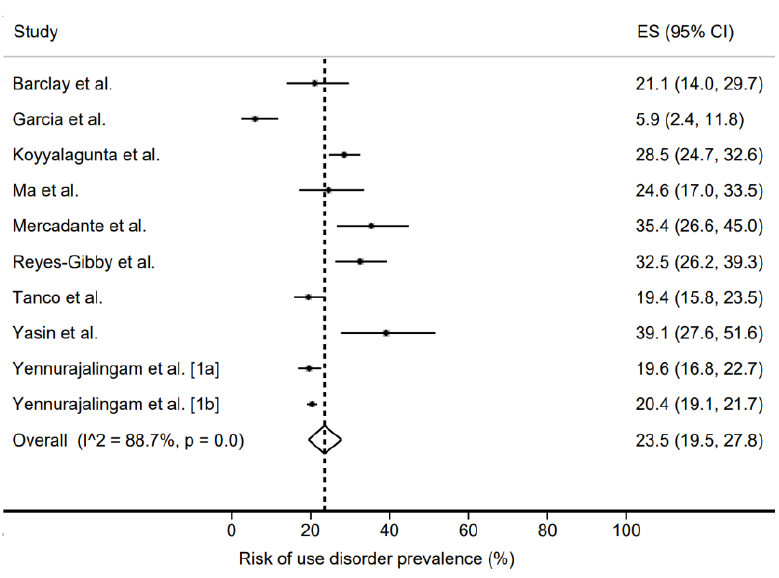
Figure 2. Use disorder prevalence [18–22].